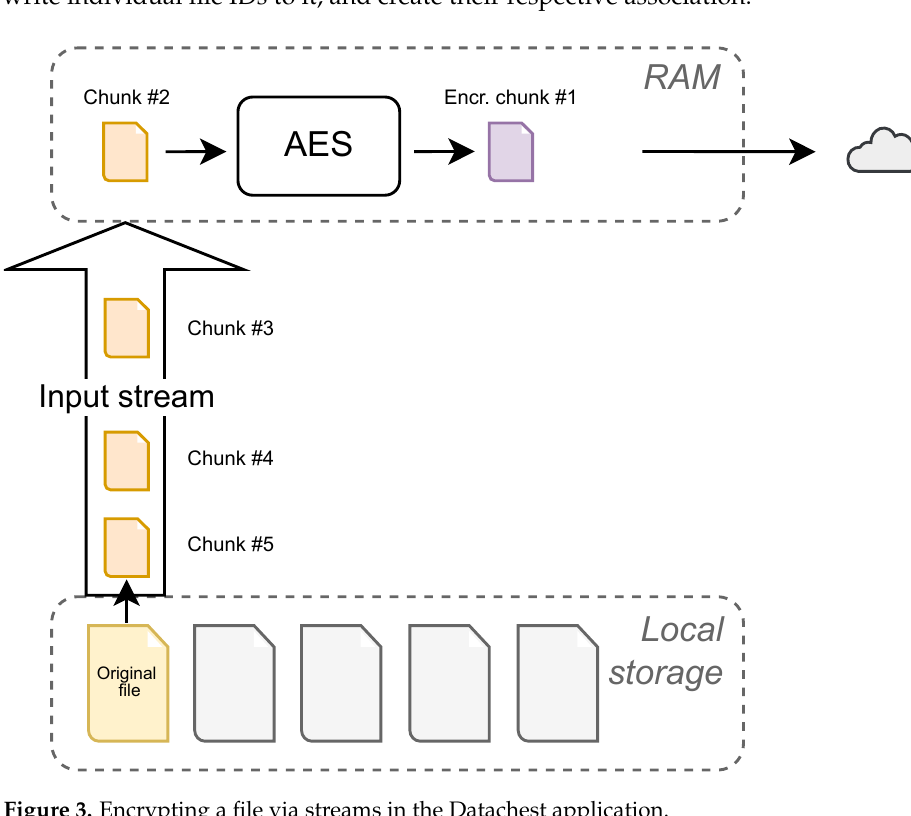
Figure 3. Encrypting a file via streams in the Datachest